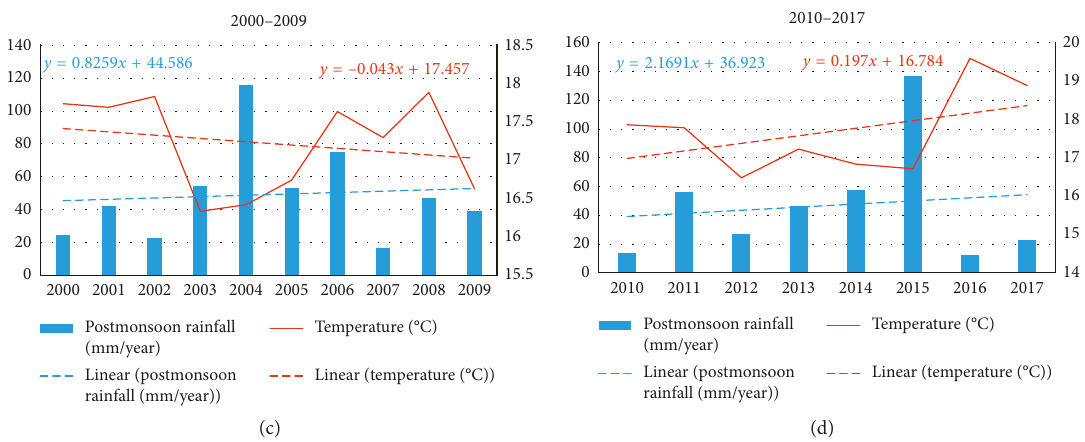
Figure 6: Decadal variations of total rainfall and seasonal mean temperature during postmonsoon season in Pakistan; all decades depict an increase in the postmonsoon rainfall and an increase in temperature except 2000–2009 where a slight decrease in temperature is observed.